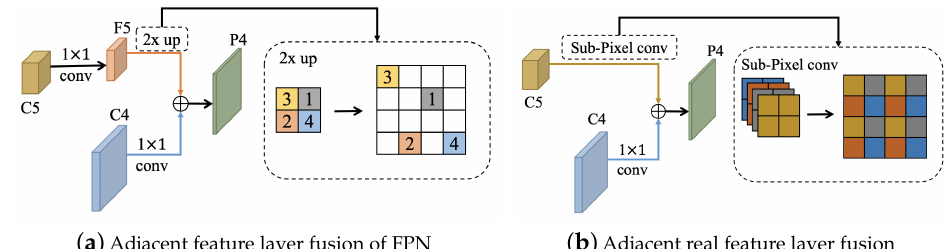
Figure 4. Two different feature fusion methods. ( a ) The feature layer is enlarged with 1 × 1 convolu- tion and upsampling. ( b ) Sub-pixel convolution is used to replace 1 × 1 convolution and upsampling to reduce the loss of real feature information in the feature